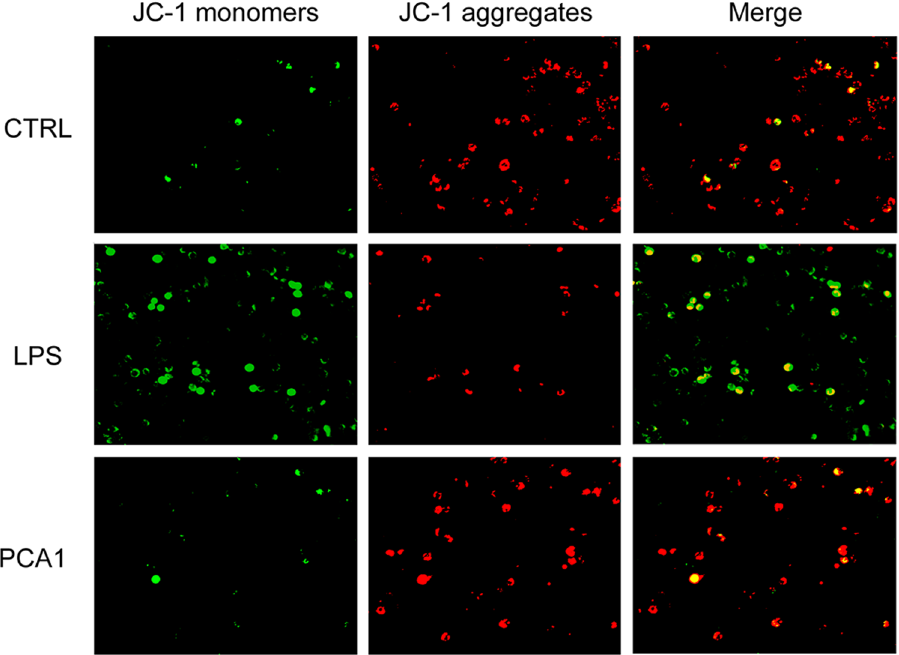
Figure 6. PCA1 reduced mitochondrial membrane potential (MMP). RAW264.7 cells treated with for PCA1 for 1 h were incubated with LPS for 8 h. The probe of JC-1 (5 μ g/mL) was employed to detect cells for 20 min. Images were captured by fluorescence